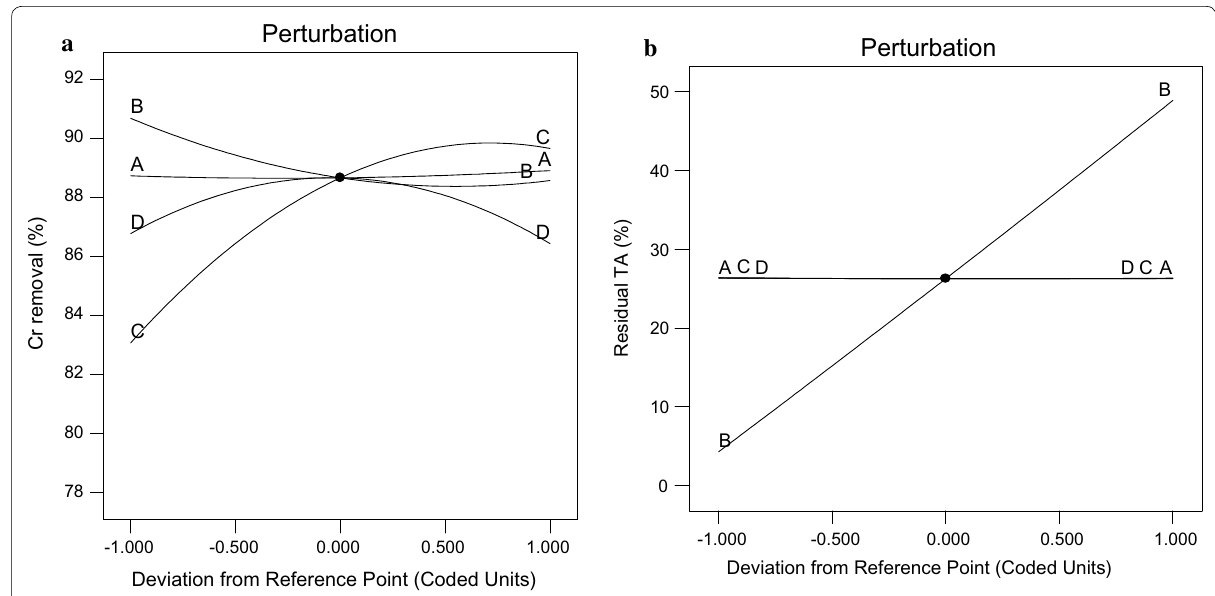
Fig. 2 Overlay plot of perturbation of A. niveus for a Cr(VI) and b Residual tannic acid. A—glucose, B—tannic acid, C—metal dose and D—NH 4